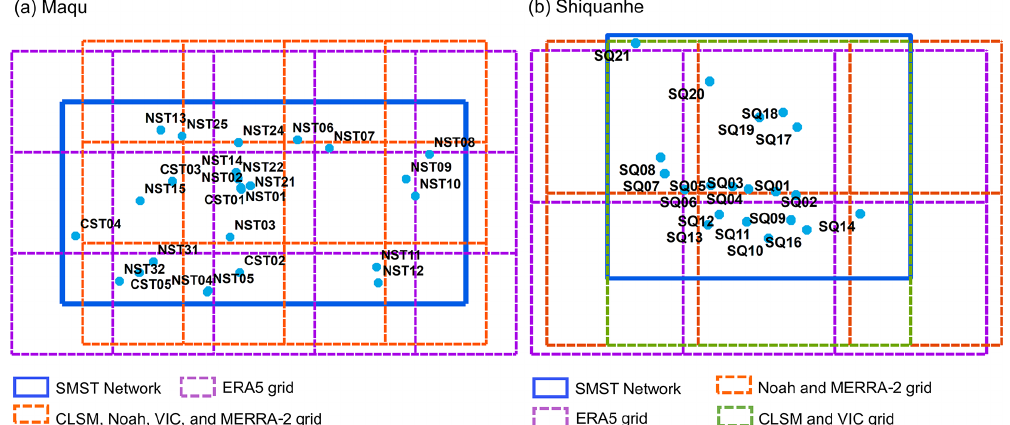
Figure B1. Grids of the model-based products falling into the (a) Maqu and (b) Shiquanhe network areas (denoted by the colourful dashed